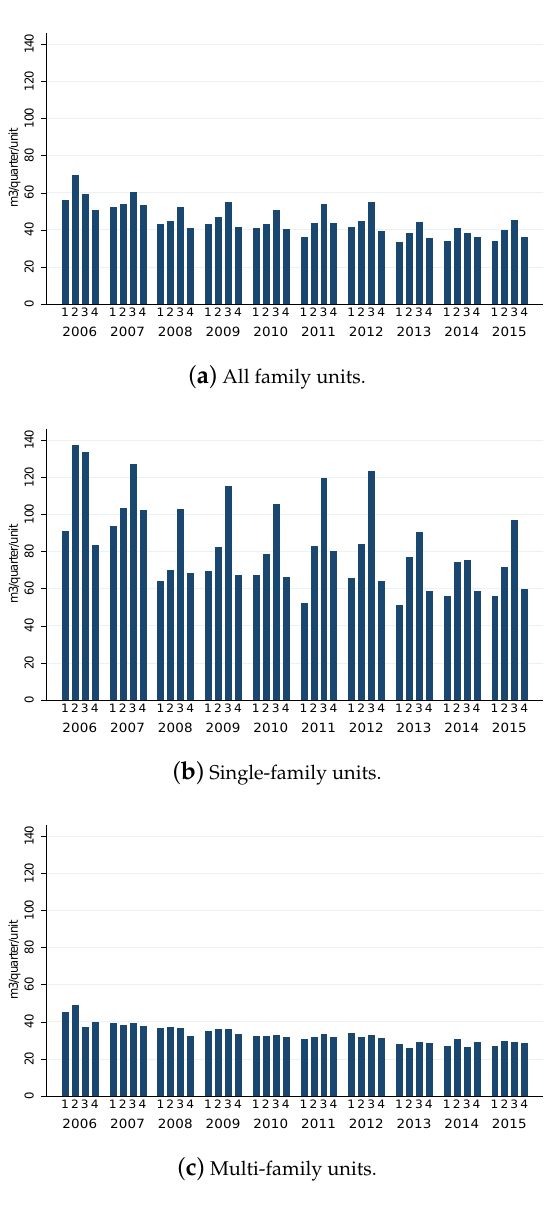
Figure 2. Average water consumption per quarter by family unit (in m 3 /quarter/unit). 1,2,3 or 4